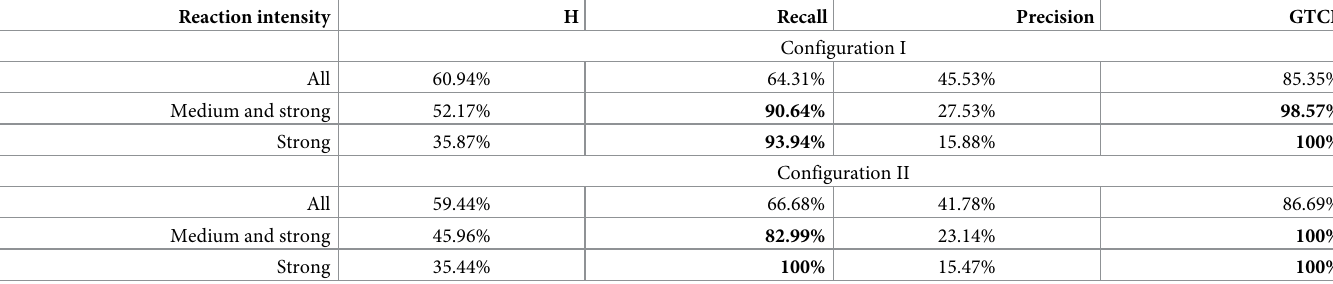
Table 2. Detailed results of the configurations I and II for pupil reactions of different intensities. Reaction